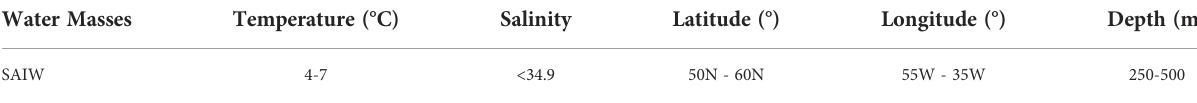
TABLE 5 Characteristics of the SAIW water mass.